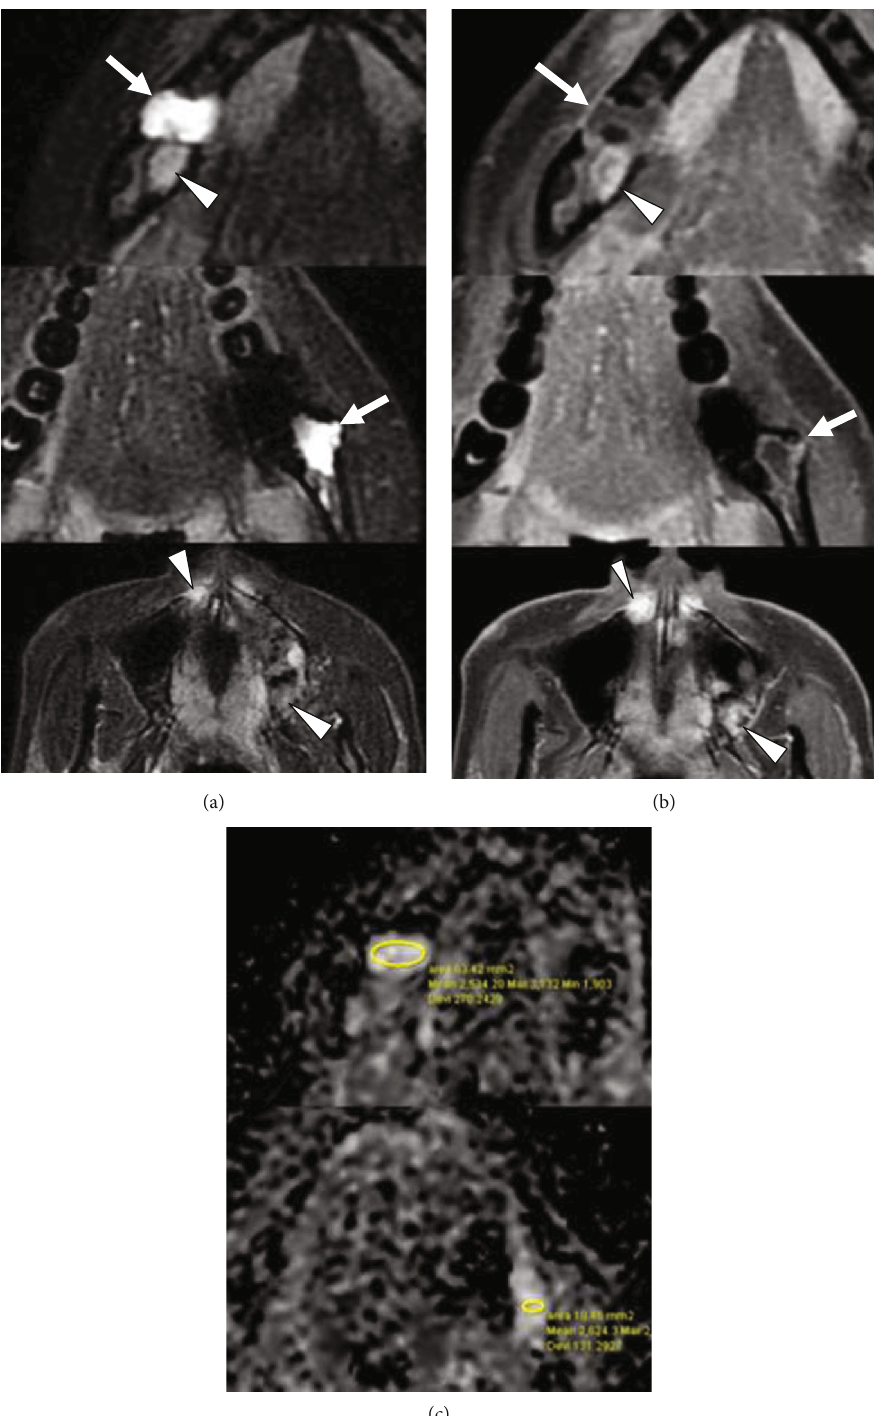
Figure 3: Magnetic resonance images. (a) Transverse fat-suppressed T2-weighted images show extremely hyperintense signal areas in the bilateral mandible ( arrows ) and hyperintense signal areas in the right mandible and bilateral maxilla ( arrowheads ). (b) Contrast-enhanced T1-weighted images show thin, peripherally enhanced lesions in the bilateral mandible ( arrows ) and heterogeneously enhanced lesions in the right mandible and bilateral maxilla ( arrowheads ). (c) The ADC maps show extremely high ADC values (over 2 : 5 × 10 − 3 mm 2 /s) at cystic areas in the bilateral mandible. ADC: apparent di ff usion coe ffi